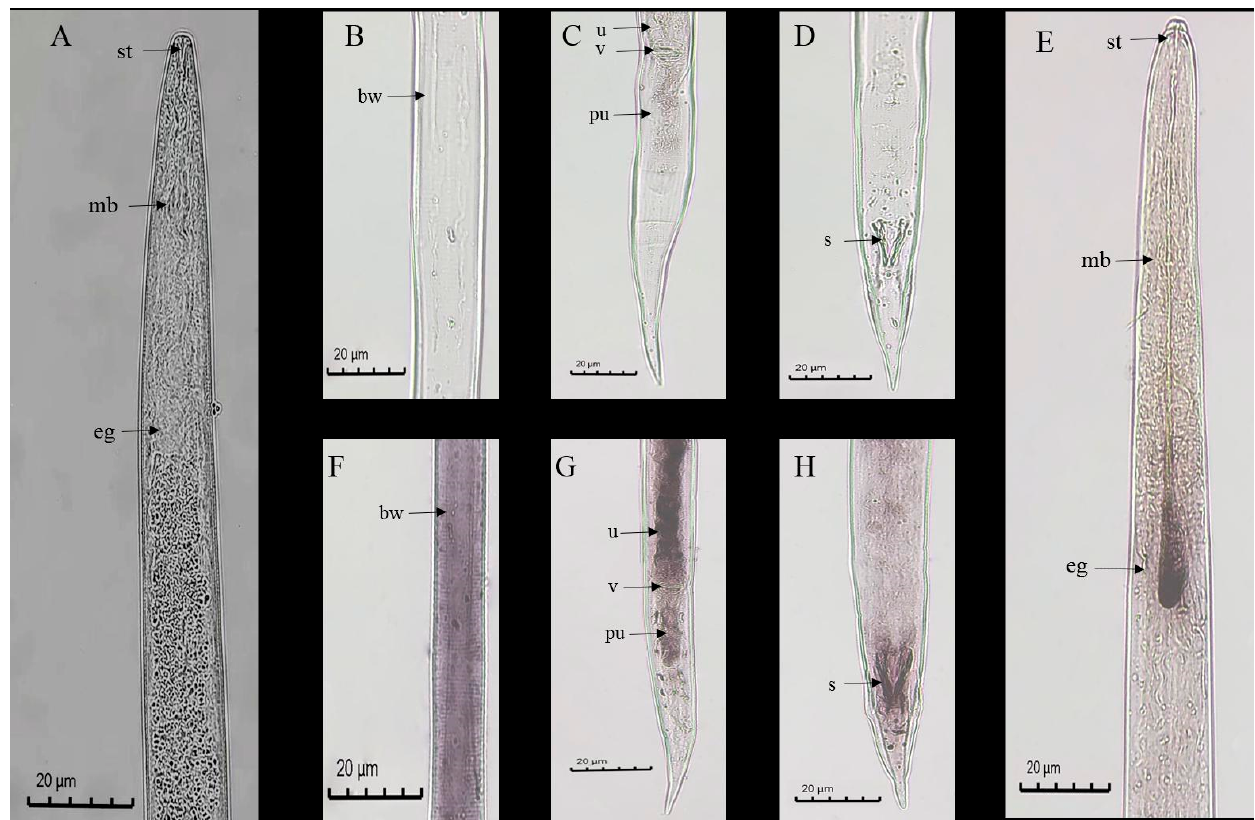
Figure 6. Tissue localization of DdCa v α 2 δ mRNA in the adult stages of D. destructor. ( A – D ): No hybridization signal was observed in D. destructor with the sense probe. ( E – H ): Tissue localization of DdCa v α 2 δ mRNA in D. destructor with the antisense probe. st: stylet; mb: median bulb; eg: esophageal glands; bw: body wall; u: uterus; v: vulva; pu: post uterine; s: spicules.